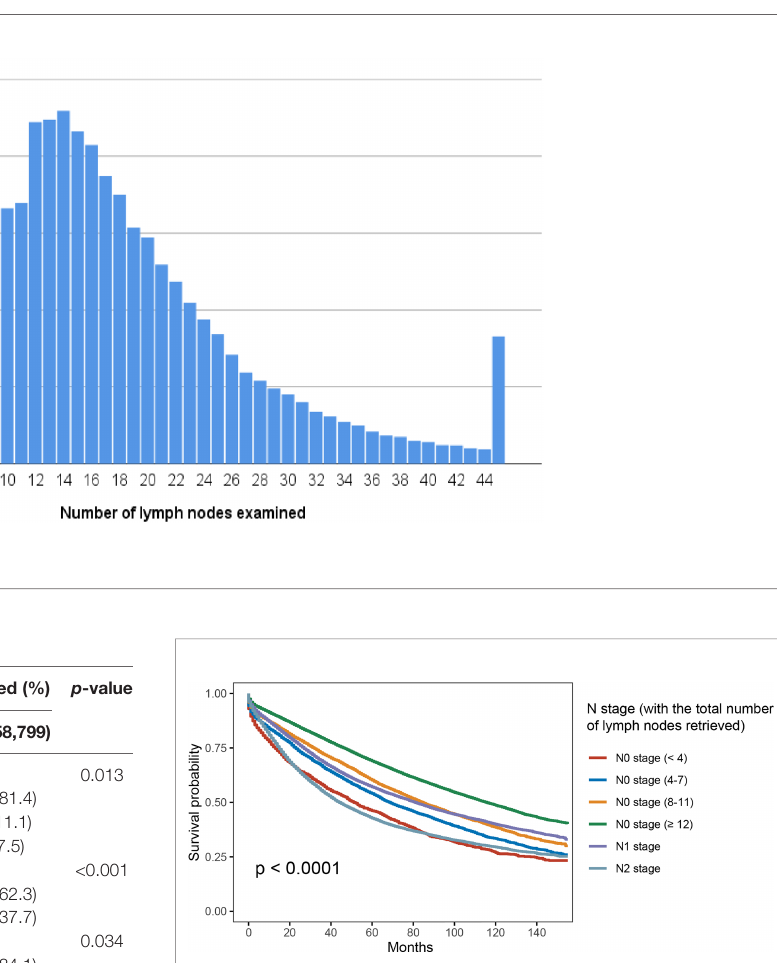
FIGURE 2 | Kaplan – Meier survival curves for colon cancer patients according to number of lymph node